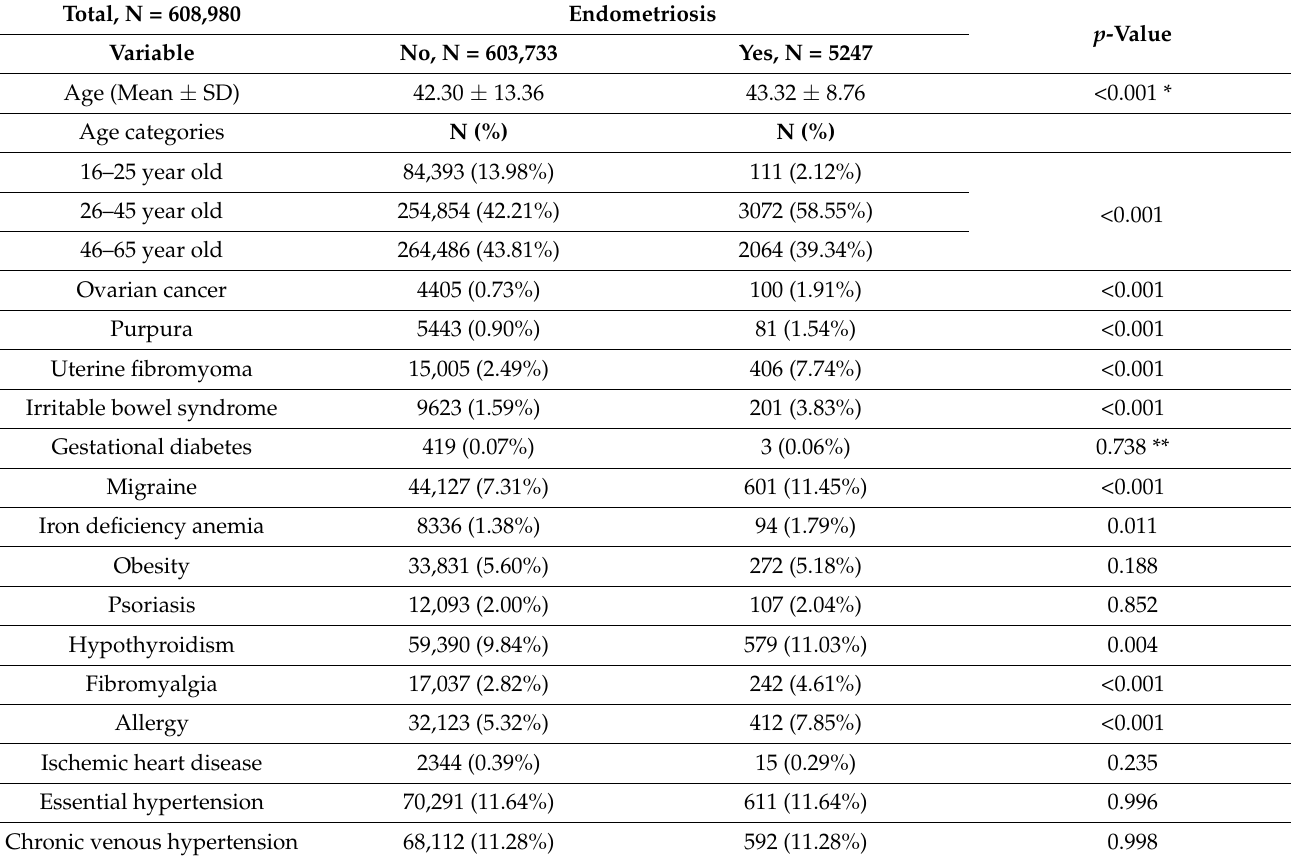
Table 3. Bivariate analysis: the relationship between endometriosis and each of the other